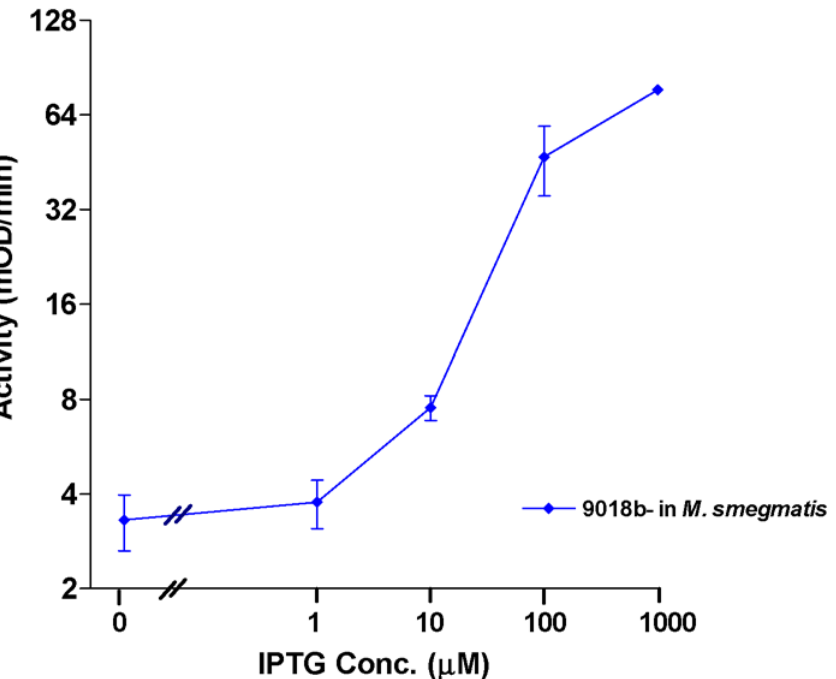
Figure 3. Validation of the inducible promoter system by b -galactosidase assay. Mycobacterium smegmatis mc 2 155 cultures harboring the plasmid pAZI 9018b were induced in triplicate with IPTG in a dose dependent manner (0,1,10,100,1000 m M). The b -galactosidase activity was monitored at O.D.410 in SpectraMax Plus 384 spectrophotometer at 37 u C after adding ONPG.